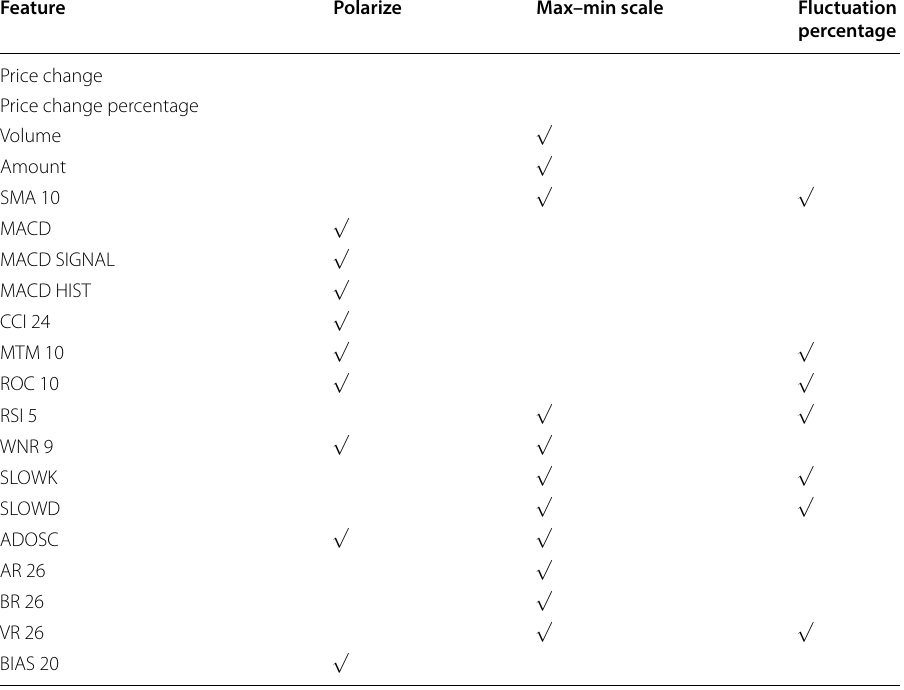
Table 2 Feature extension method